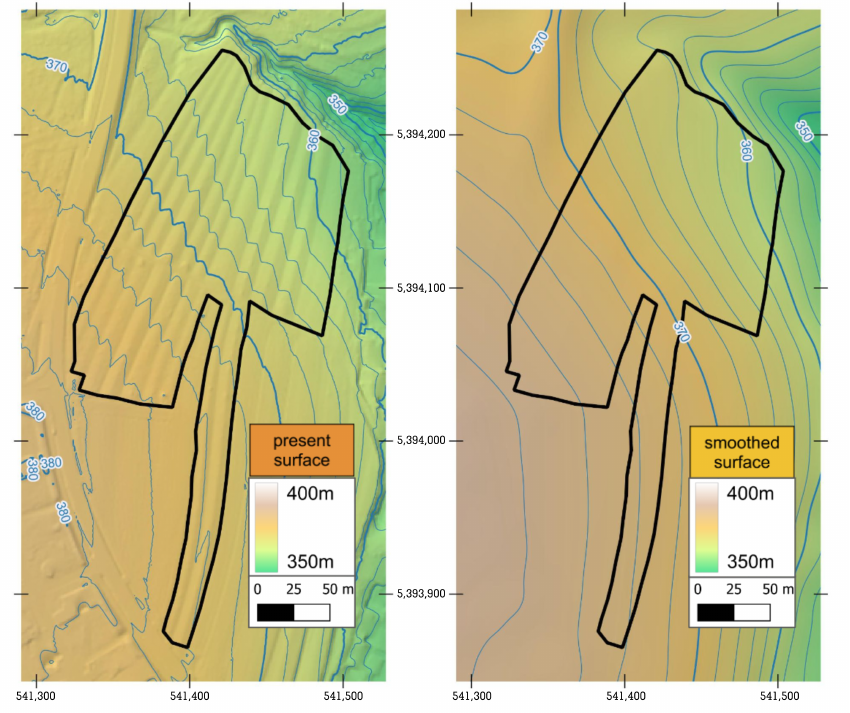
Figure 3. Comparison of the present ( left ) and smoothed ( right ) surface topography based on the LiDAR DEM (©www.lgl-bw.de (accessed on 24 January 2023)) [36]. The black line frames the classified cultural site within the plot Höfelbett